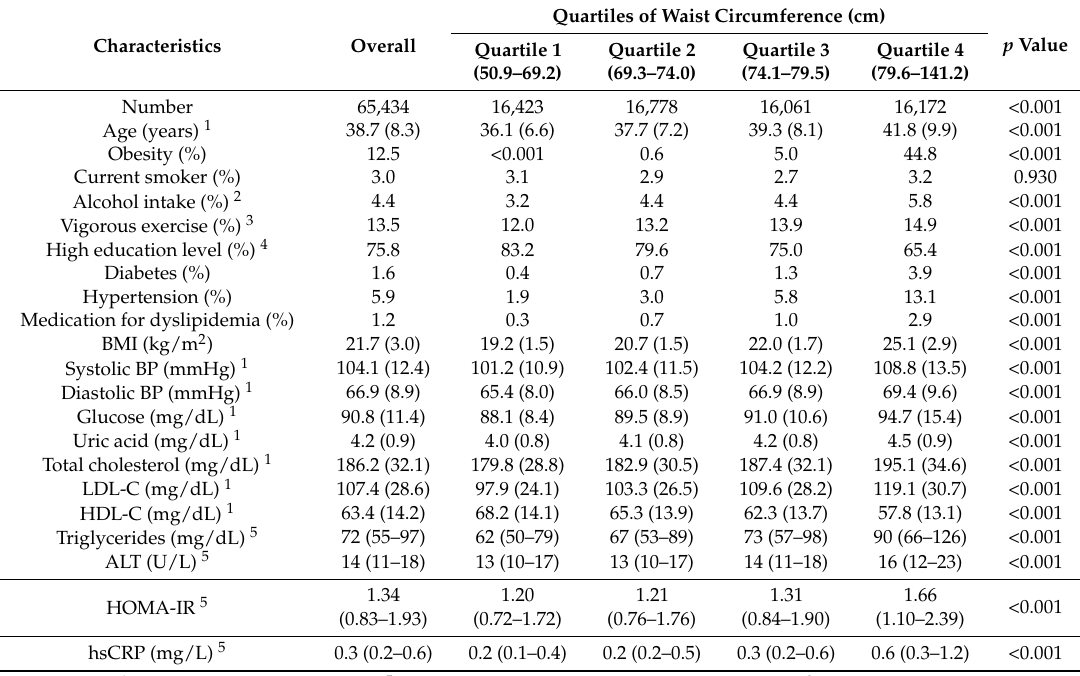
Table 2. Baseline characteristics of study participants by waist circumference among